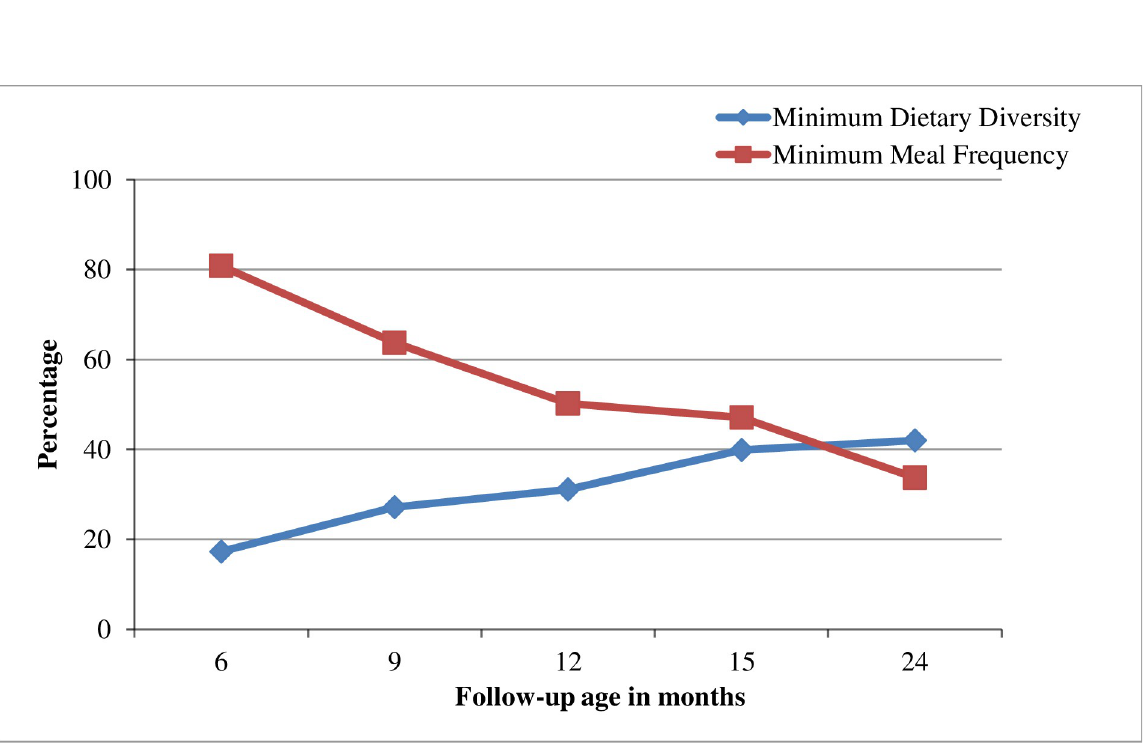
PLOS ONE | https://doi.org/10.1371/journal.pone.0250562 May 13,